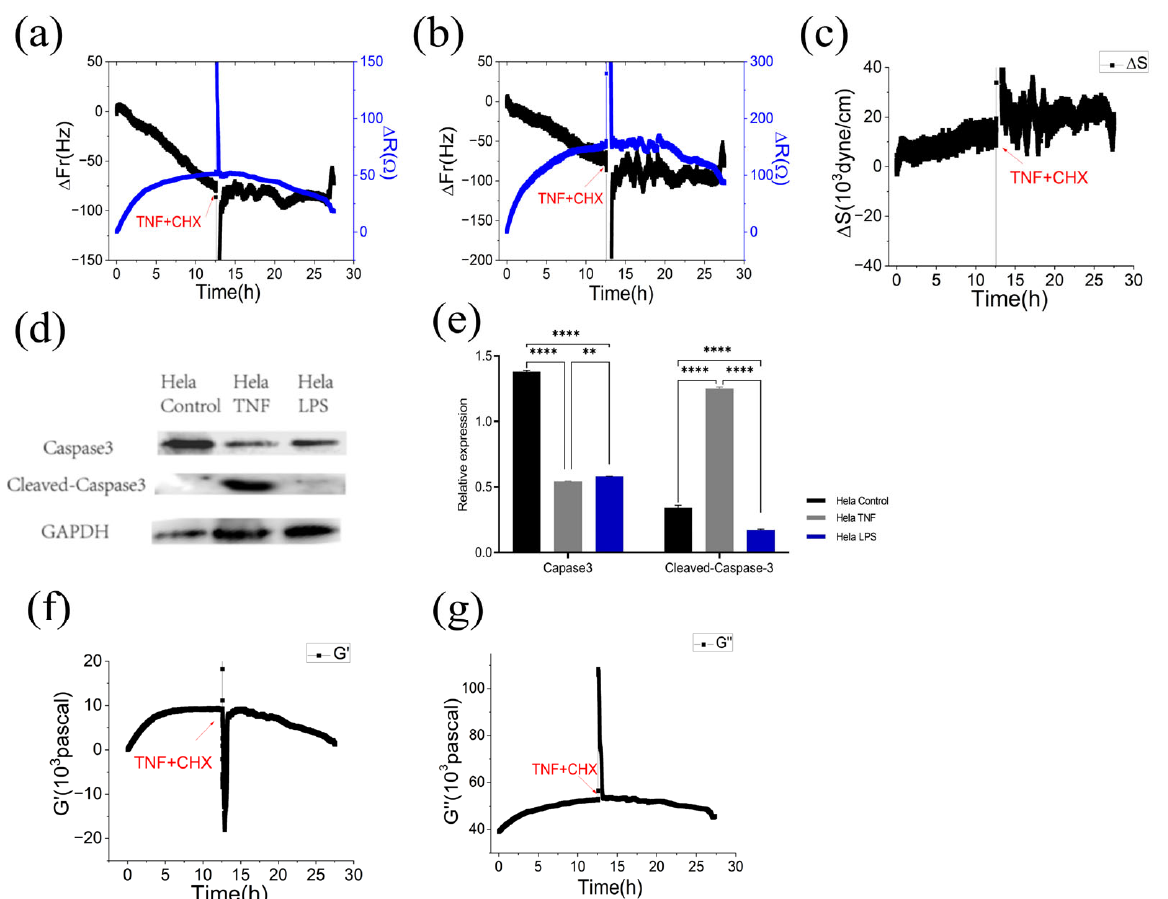
Figure 2. Dynamic QCM responses and cytomechanical parameters recorded during TNF and CHX induced apoptosis in 2000 HeLa cells. ( a , b ) Frequency shifts and motional resistance changes on AT ( a ) and BT ( b ) cut quartz crystals; ( c ) Cells generated force on quartz crystal; ( d ) Effects of apoptosis induced by TNF and CHX on Caspase3 cleavage through Western blot assay. The loading control is GAPDH expression; ( e ) The relative expression of target protein/GAPDH was analysed by Image ‐